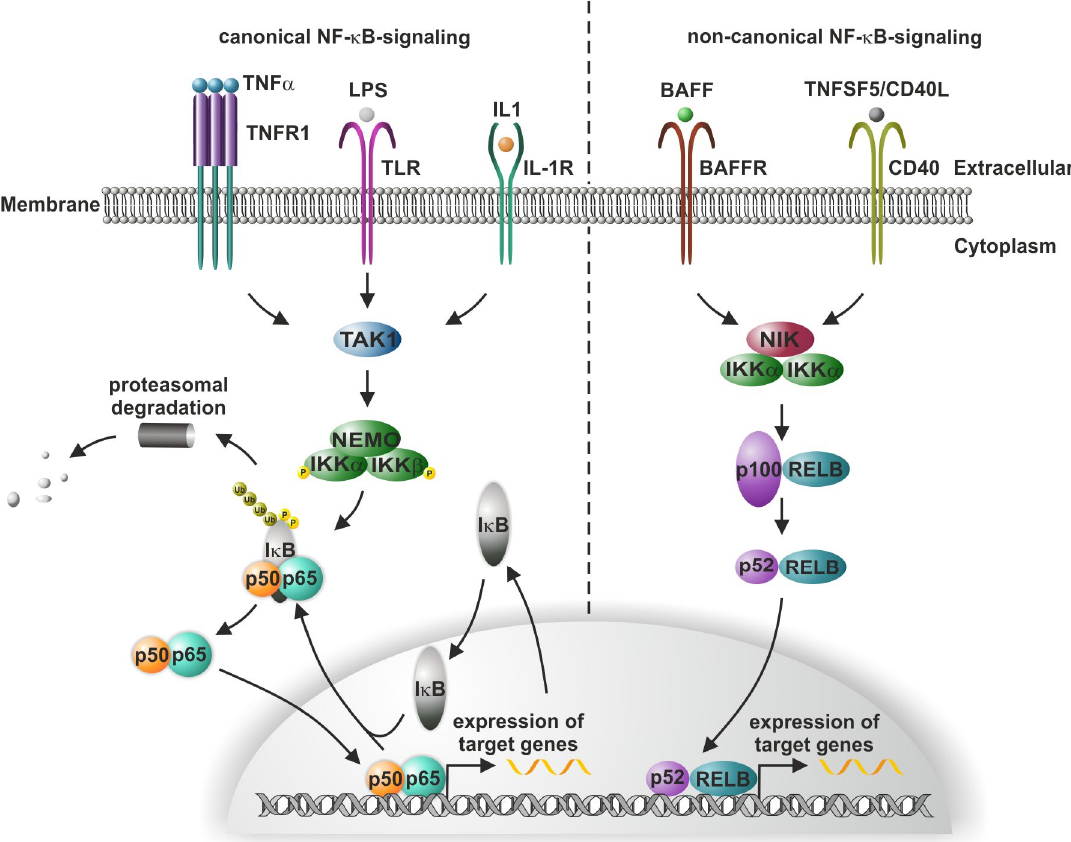
Figure 1. Schematic view of canonical and non-canoncial NF-κB signaling in mammals. In canonical signaling, NF-κB exists in two forms: a latent form complexed with IκB retained within the cytoplasm, and activated NF-κB without inhibitory subunits, binding to DNA in the nucleus. Various extracellular stimuli activate NF-κB, such as bacterial and viral products, inflammatory cytokines, reactive oxygen species, ultraviolet light, and even neurotransmitters. Intracellularly, a kinase complex (IKK, IκB kinase) is activated, in turn, resulting in phosphorylation and linear ubiquitination of the heterodimer-associated IκB. Rapid degradation of IκB through ubiquitin-mediated proteasomal degradation is followed by nuclear import of NF-κB and binding to target gene promoters such as IκB. Later, IκB can enter the nucleus and terminate the expression of NF-κB-target genes. In non-canonical signaling, binding of ligands to respective receptors such as BAFFR leads to NF-κB-inducing kinase (NIK)-mediated phosphorylation of IKK1, which in turn results in processing of p100 to p52 and enables the translocation of p52/RELB into the nucleus and the initiation of target gene transcription. Expression patterns in human single cells measured by RNA sequencing differed considerably. Whereas RELA has low cell type-specificity, c-REL is predominantly expressed in monocytes and keratinocytes and RELB in monocytes and glandular cells (The Human Protein Atlas, www.proteinatlas.org (accessed on 23 July 2021)).